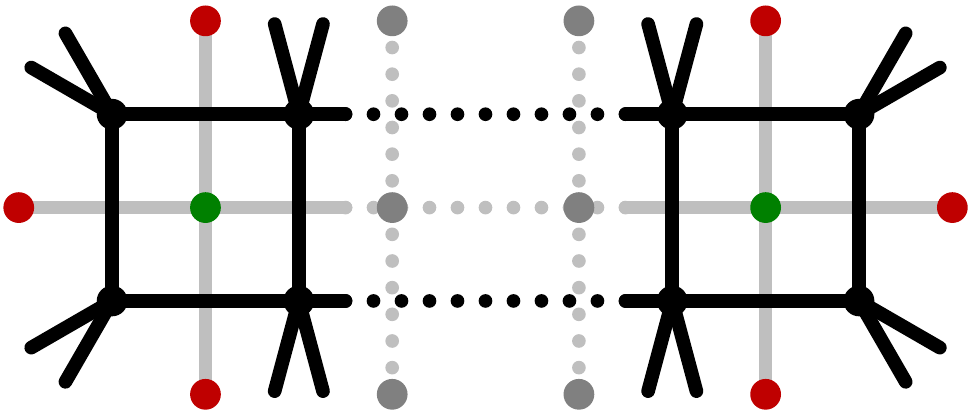
Figure 1 . The traintrack